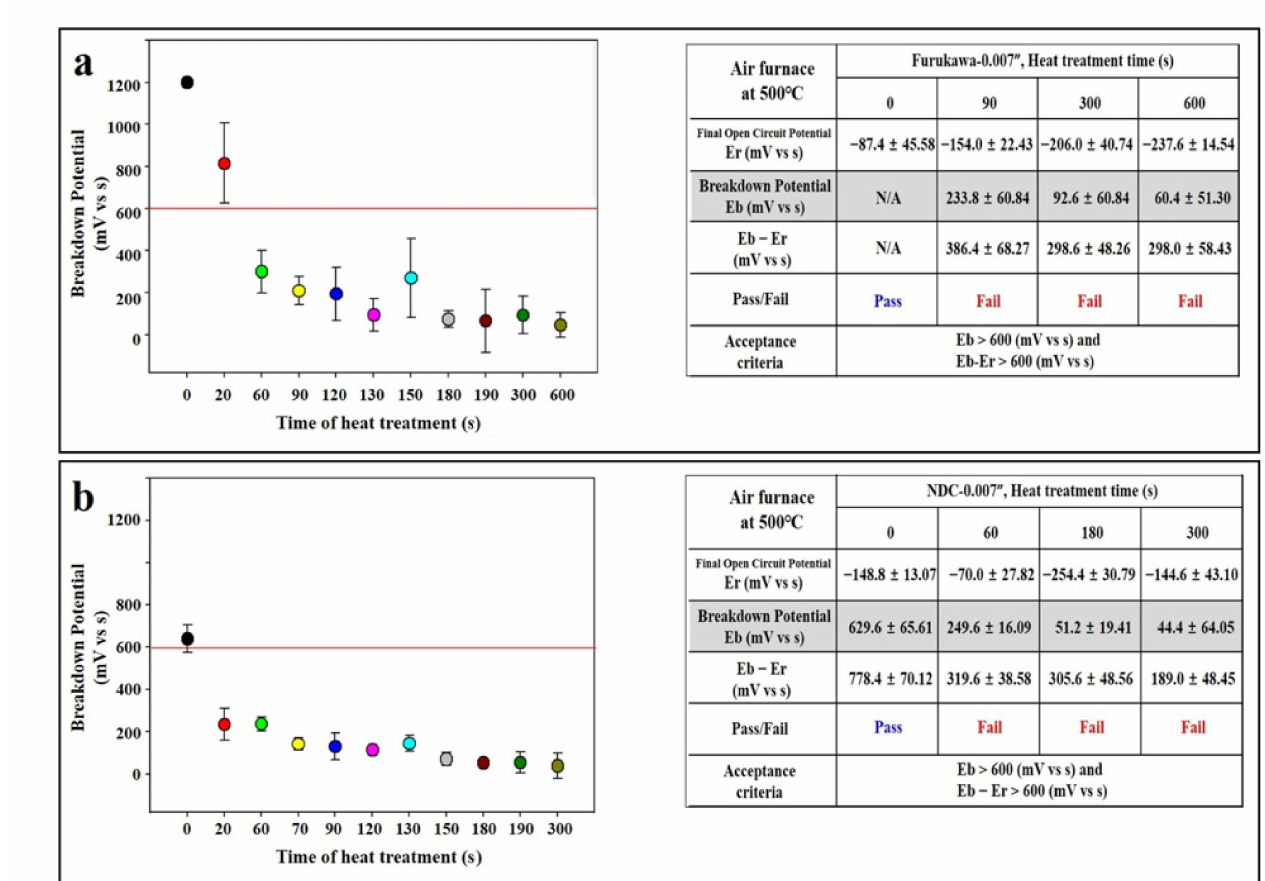
Figure 2. Heat treatment of wires in air furnace. ( a ) Furukawa and ( b ) NDC wire. Red lines indicate acceptance criteria in this study as mentioned in Materials and Methods section. ‘F’ and ‘N’ are acronyms for ‘Furukawa’ and ‘NDC’,